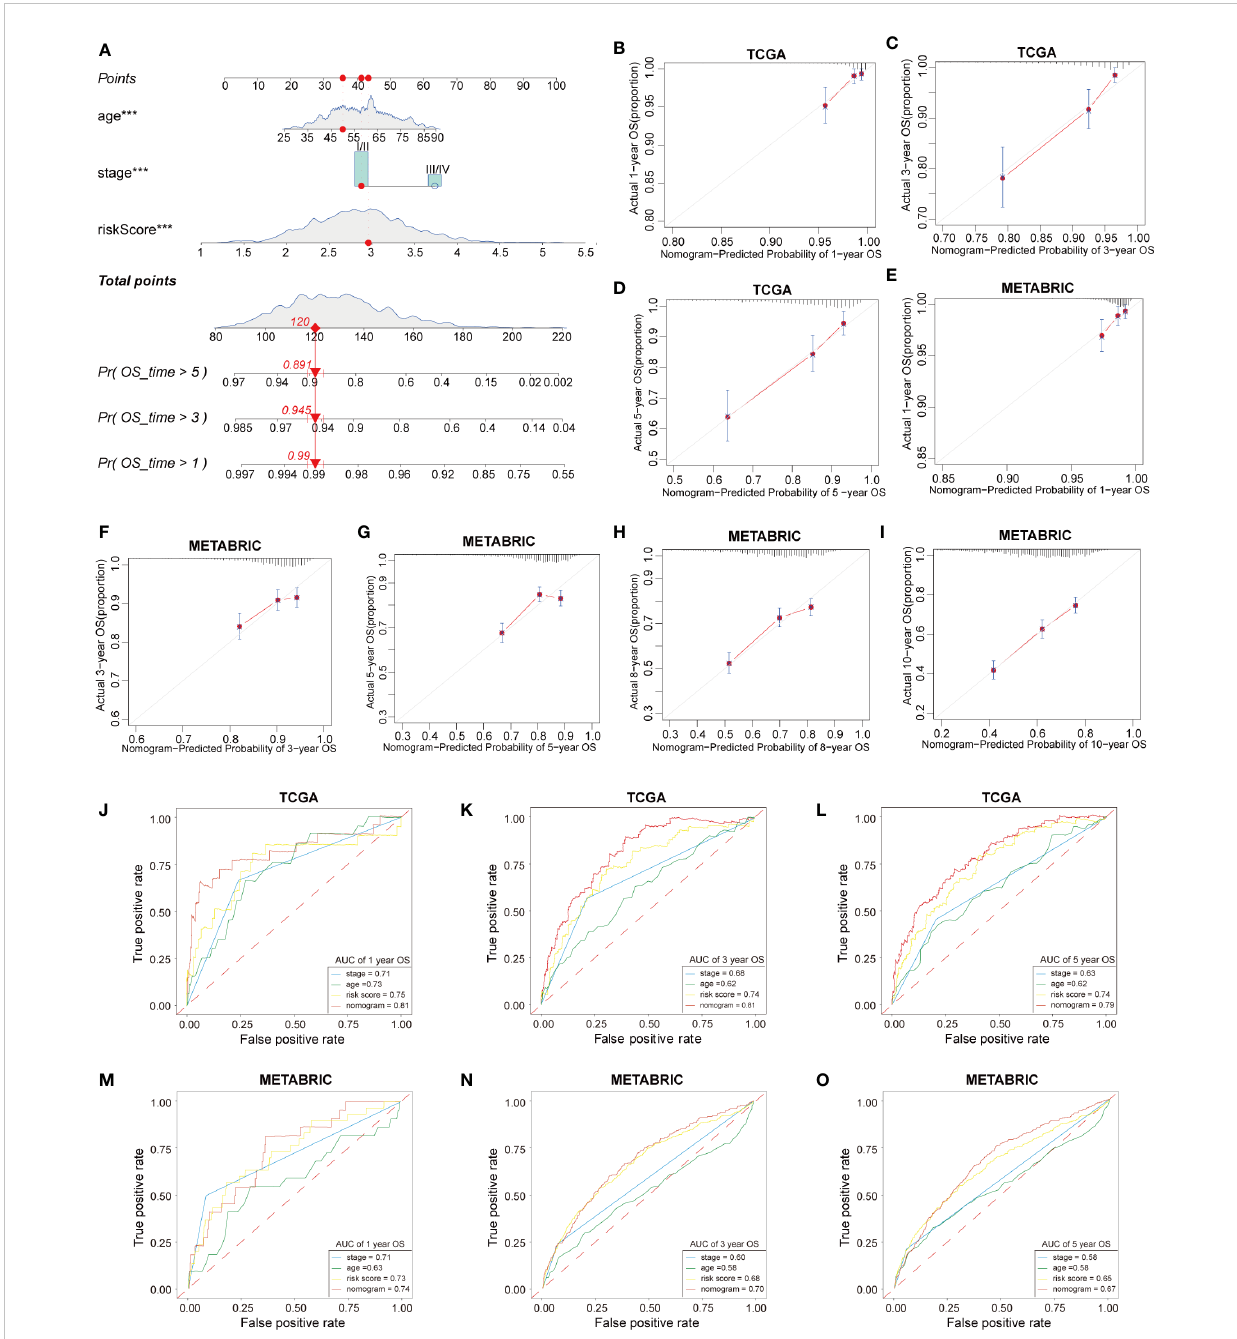
FIGURE 8 Construction and validation of nomogram. (A) The nomogram based on HFRS risk score, age and tumor stage for predicting overall survival of BC patients. (B – D) Calibration plots of the nomogram for predicting the probability of OS at 1, 3, and 5 years in the TCGA cohort. (E-I) The calibration plots of the nomogram for predicting 1-, 3-, 5-, 8-, and 10-year OS in the METABRIC cohort. (J – L) ROC curves of nomogram, risk score, tumor stage, age for predicting 1-, 3-, 5-year OS in the TCGA cohort. (M – O) ROC curves of nomogram, risk score, tumor stage, age for predicting 1-, 3-, 5-year OS in the METABRIC